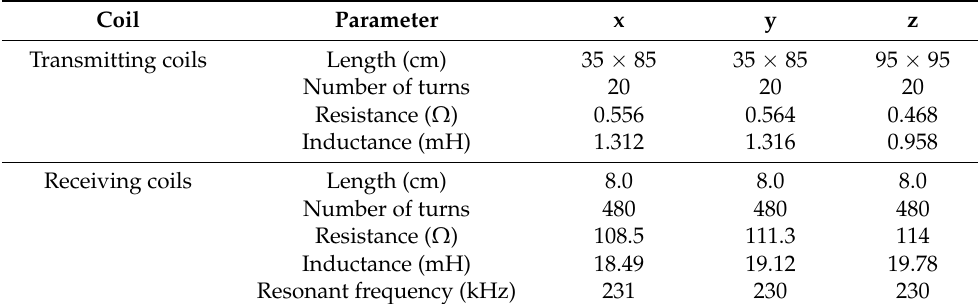
Table 1. Parameters of the towed sensor.